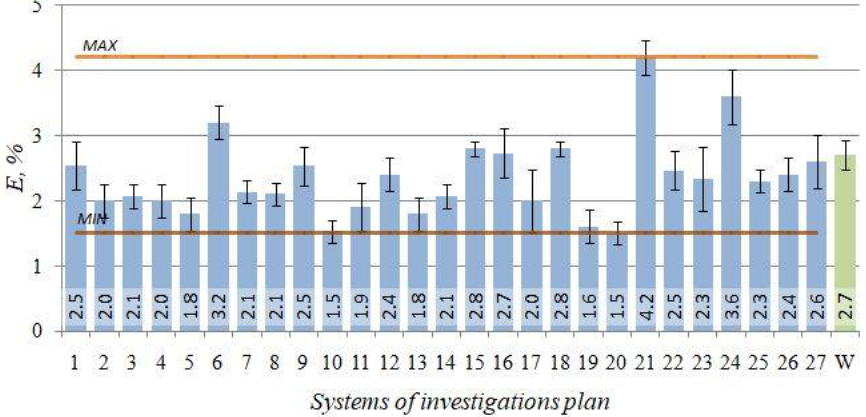
Figure 6. Unit elongation E—the initial state (W) and after T6 heat treatment (1–27) for the EN AC–AlSi11(Fe) alloy.